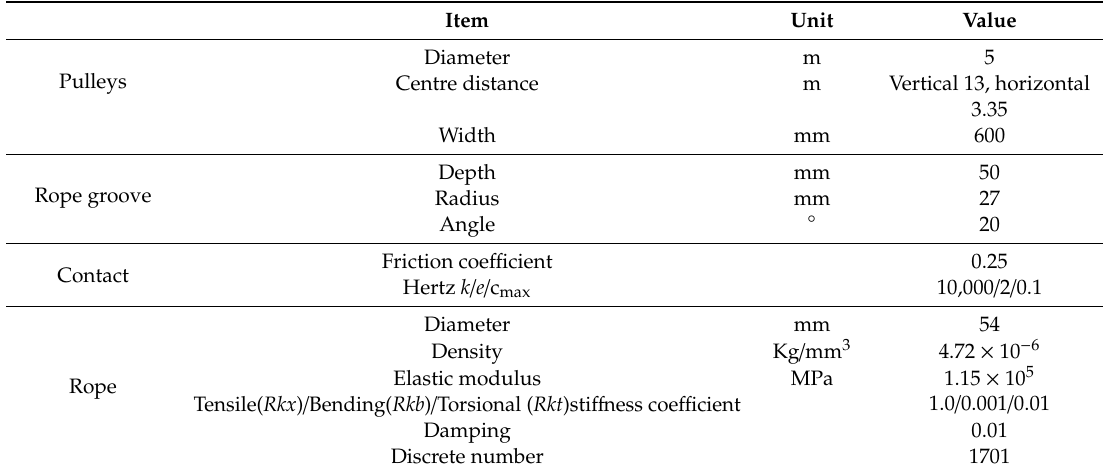
Table 3. Parameters of the global hoisting